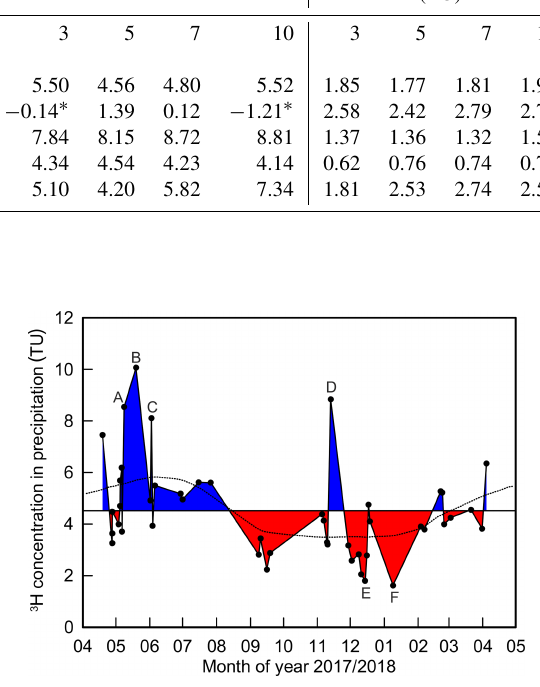
Figure 4. Time series of the measured tritium concentration of pre- cipitation events. The horizontal line is the mean of all measured tritium concentrations. Blue areas are above and red areas are be- low the mean concentration. The dotted line is a LOESS regression of the measured